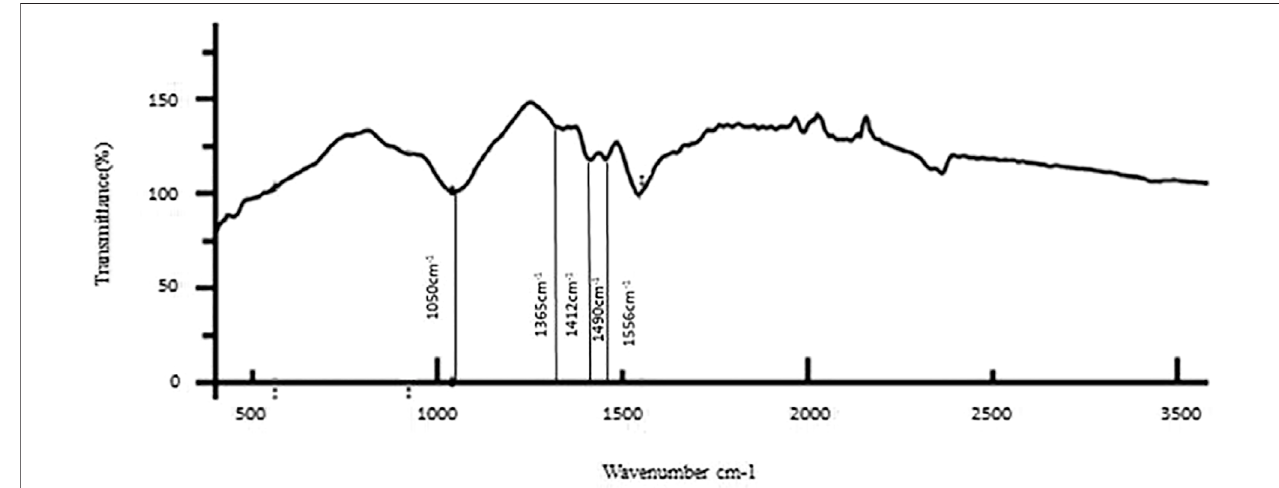
FIGURE 3 | Bioactive evaluation of glass ionomer cement (GIC) with dentin.